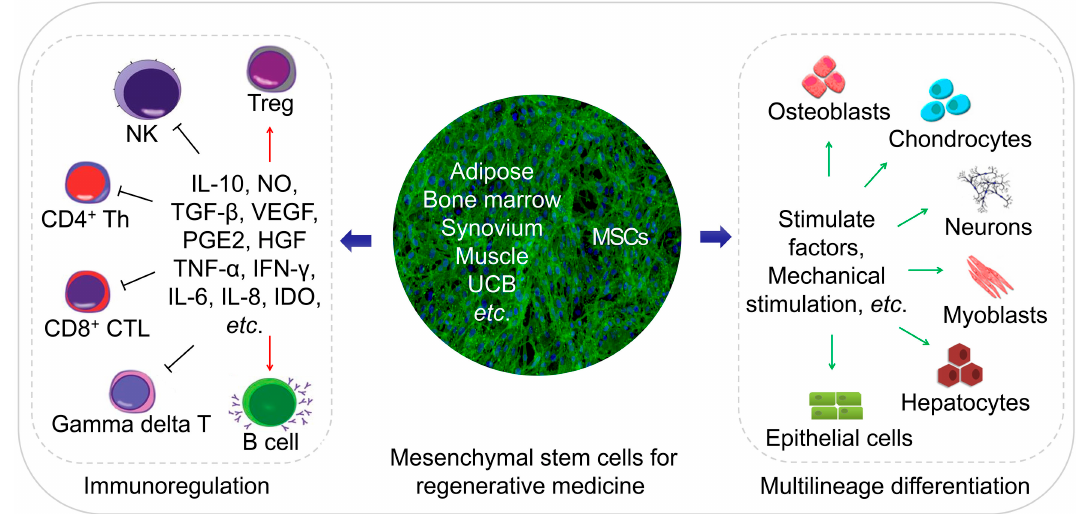
Figure 1. Schematic diagram of regenerative medicine based on mesenchymal stem cells (MSCs).